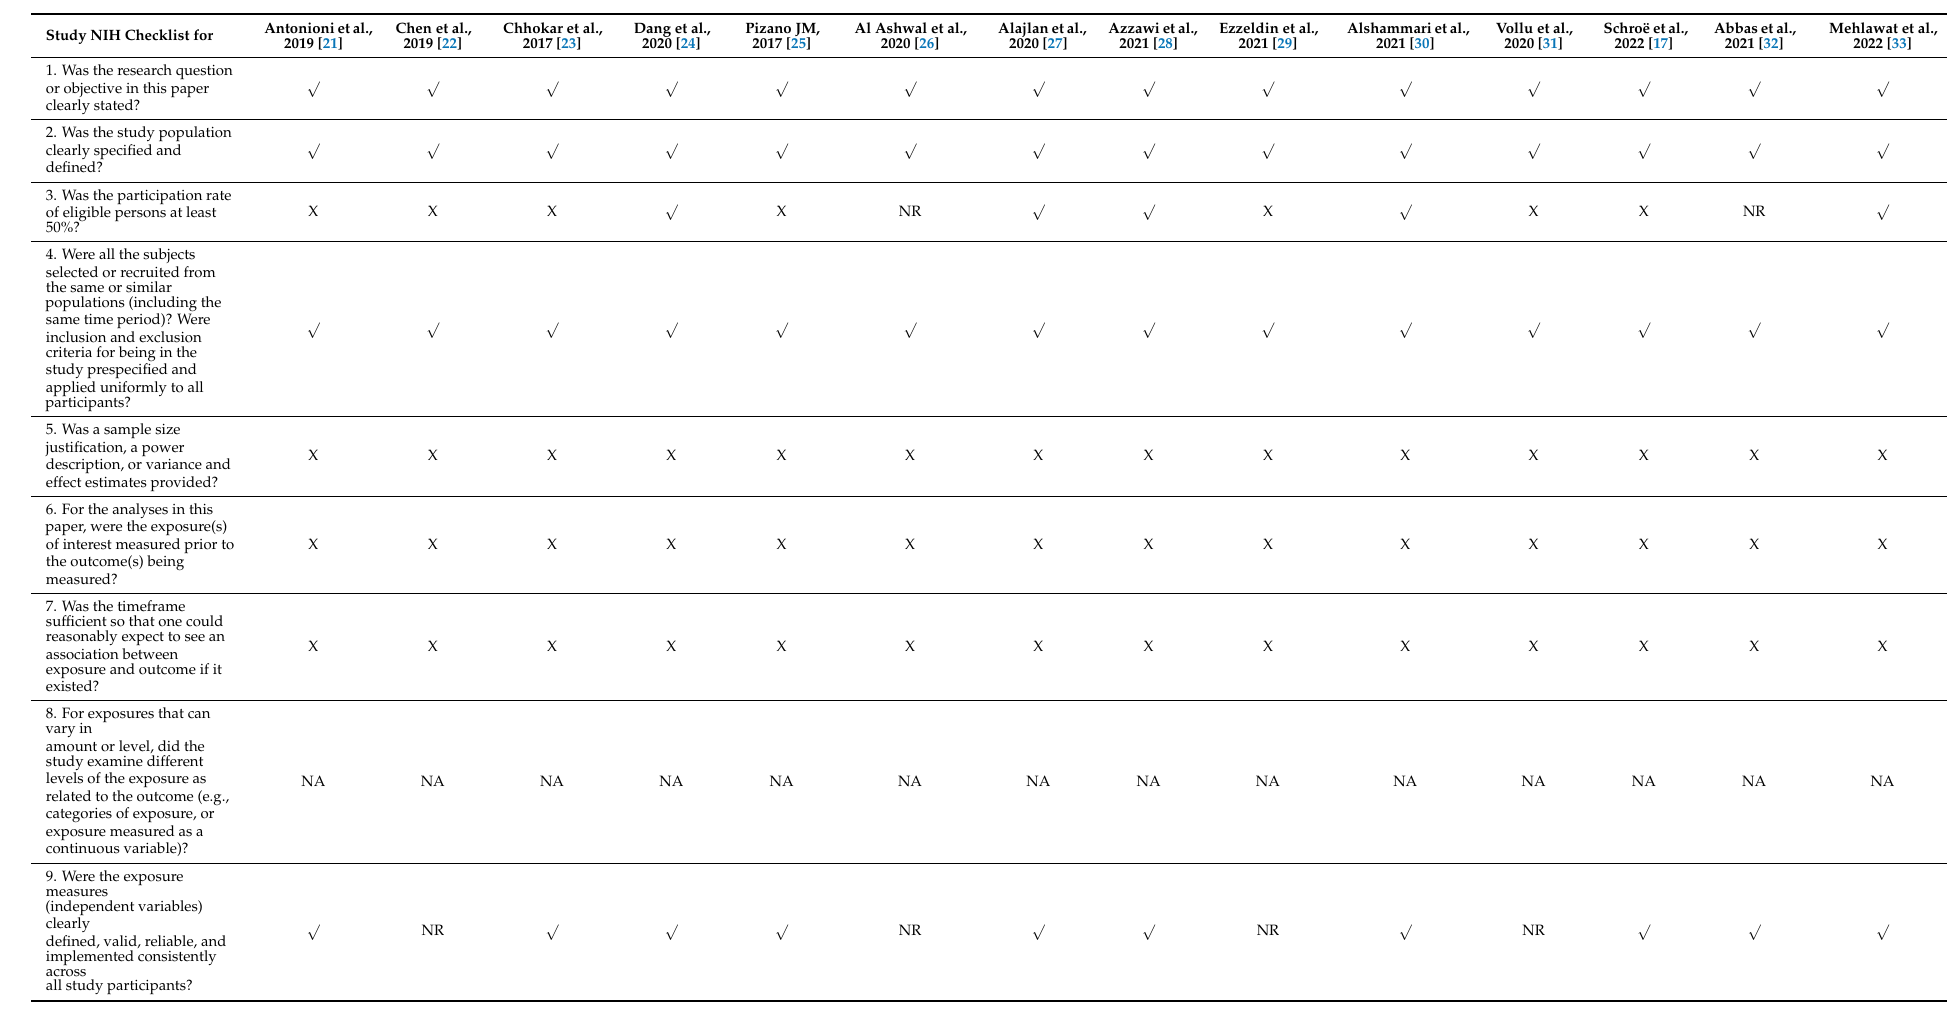
Table A5. Assessment of Quality for Included